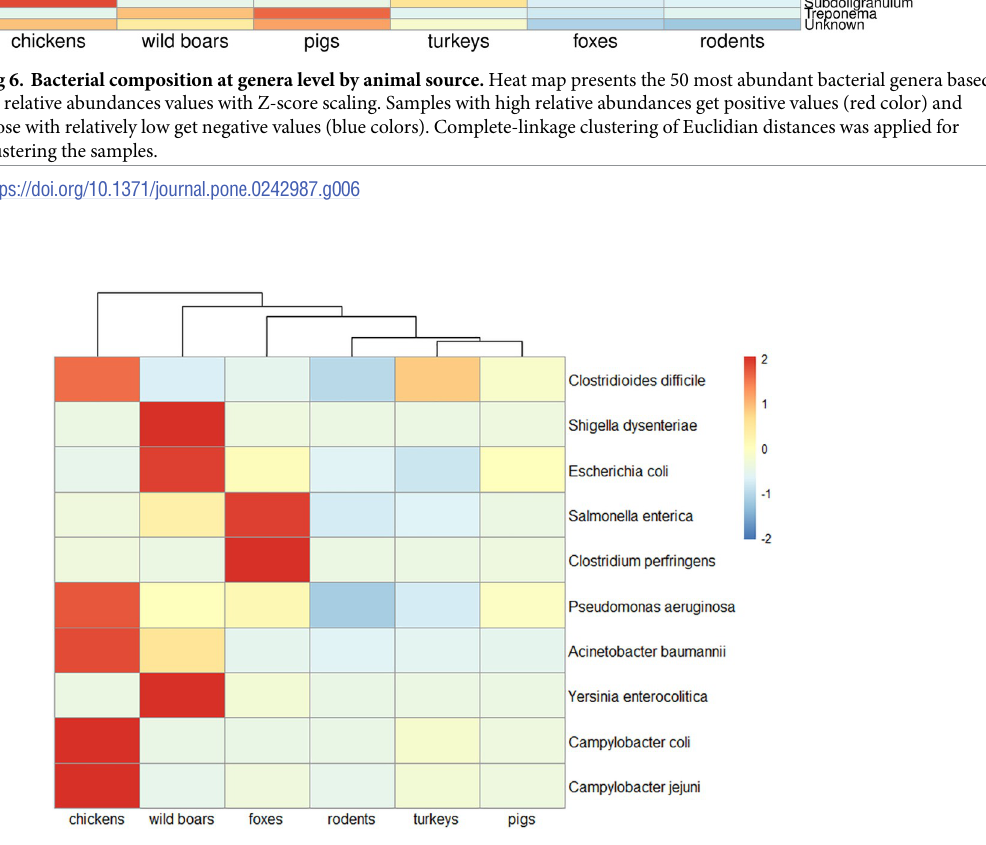
PLOS ONE | https://doi.org/10.1371/journal.pone.0242987 December3,